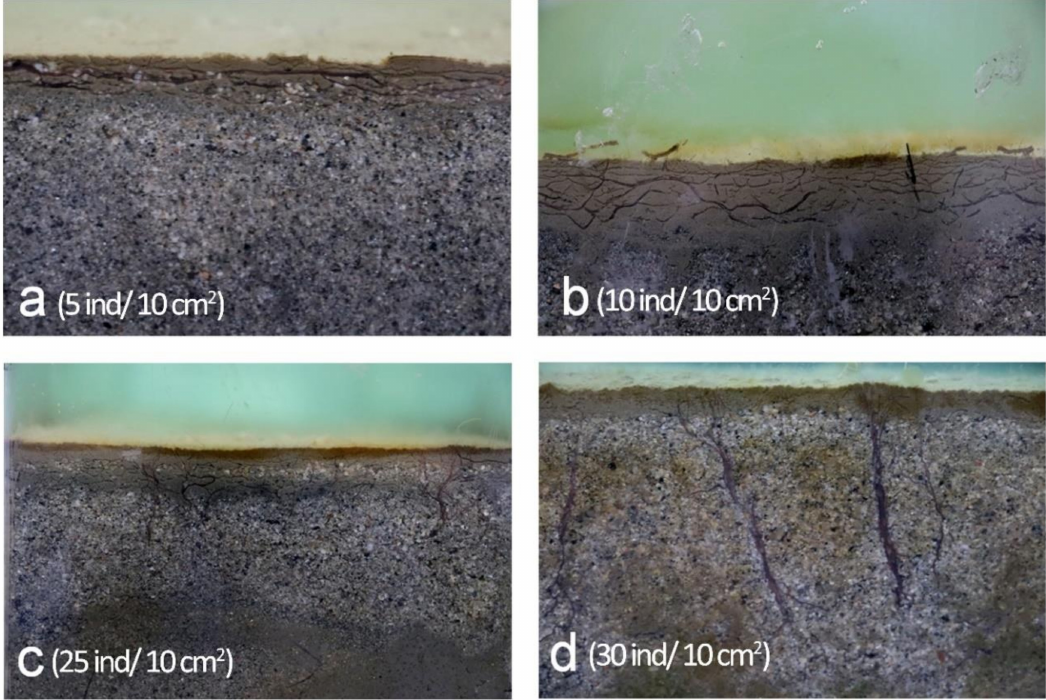
Figure 3. Activity and distribution of tubificid worms in di ff erent densities (( a ) flume 1; ( b ) flume 2; ( c ) flume 5; ( d ) flume